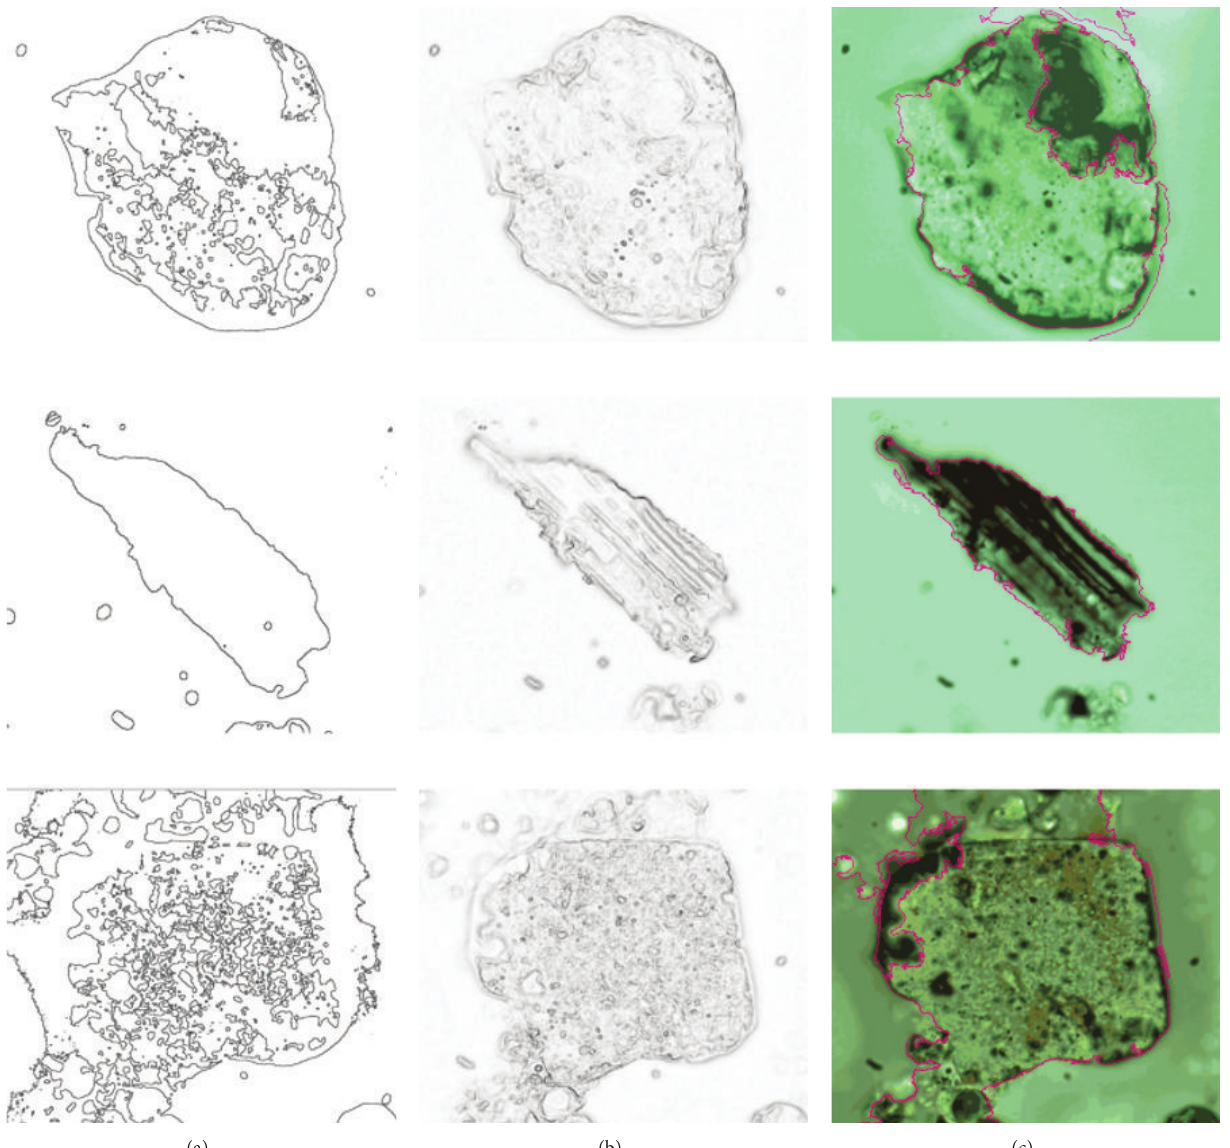
Figure 8: The comparison between proposed method and traditional